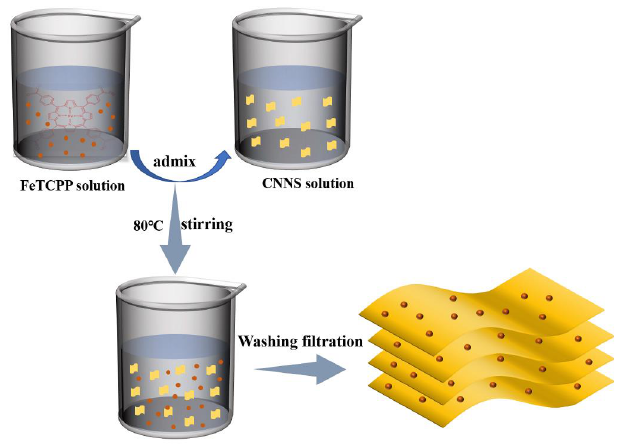
Figure 1. Schematic illustration of preparation process for FeTCPP@CNNS.